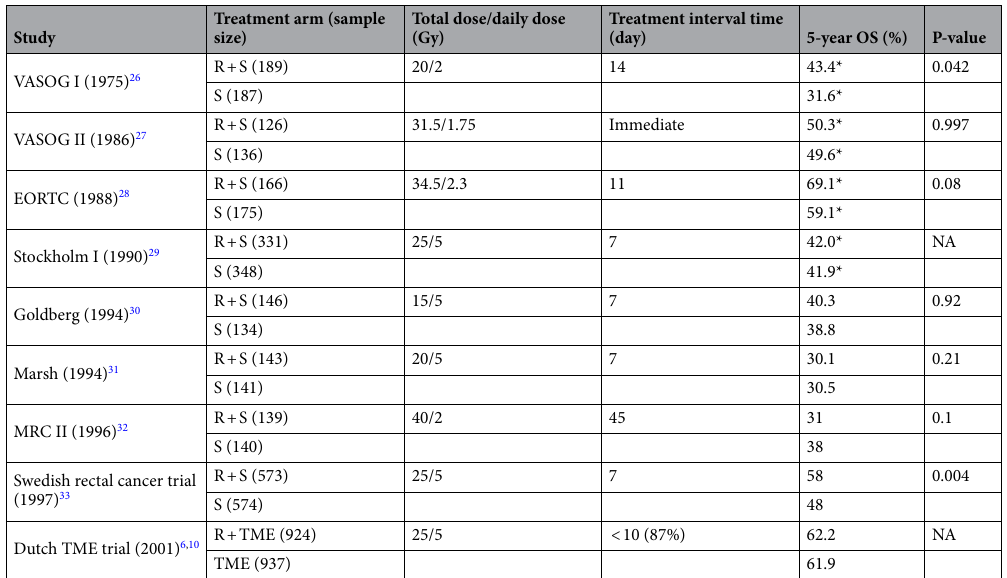
Table 4. Overall survival in rectal cancer associated with neoadjuvant radiotherapy among phase III RCTs. R radiotherapy, S surgery, TME total mesorectal excision, NA not applicable, RCTs randomized clinical trials. *Analysis of the results of patients undergoing radical